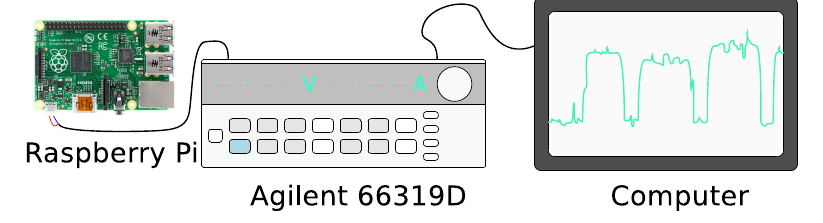
Figure 3. Energy measurement